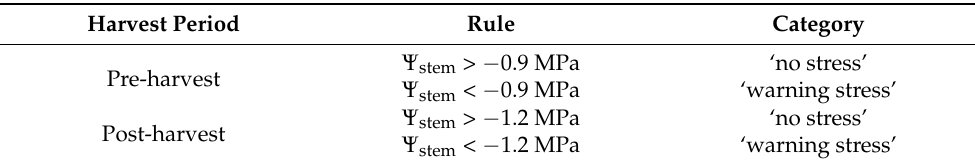
Table 1. Defined rule for binary categorization of crop water stress.